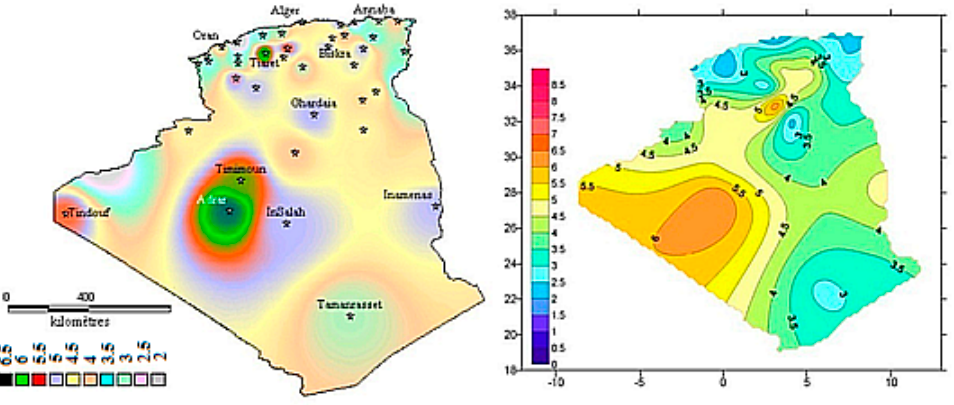
Figure 15. Map showing wind speed measurement 10 m AGL in Algeria [92].